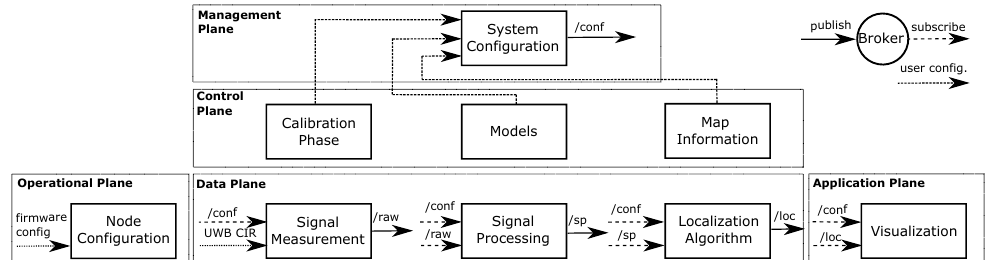
Figure 4. The DFL system design implements a publish/subscribe pattern for message exchange and inter-process communication. The function blocks, except the node configuration, are MQTT clients, that publish and subscribe data from the MQTT broker. The control plane provides information for the system